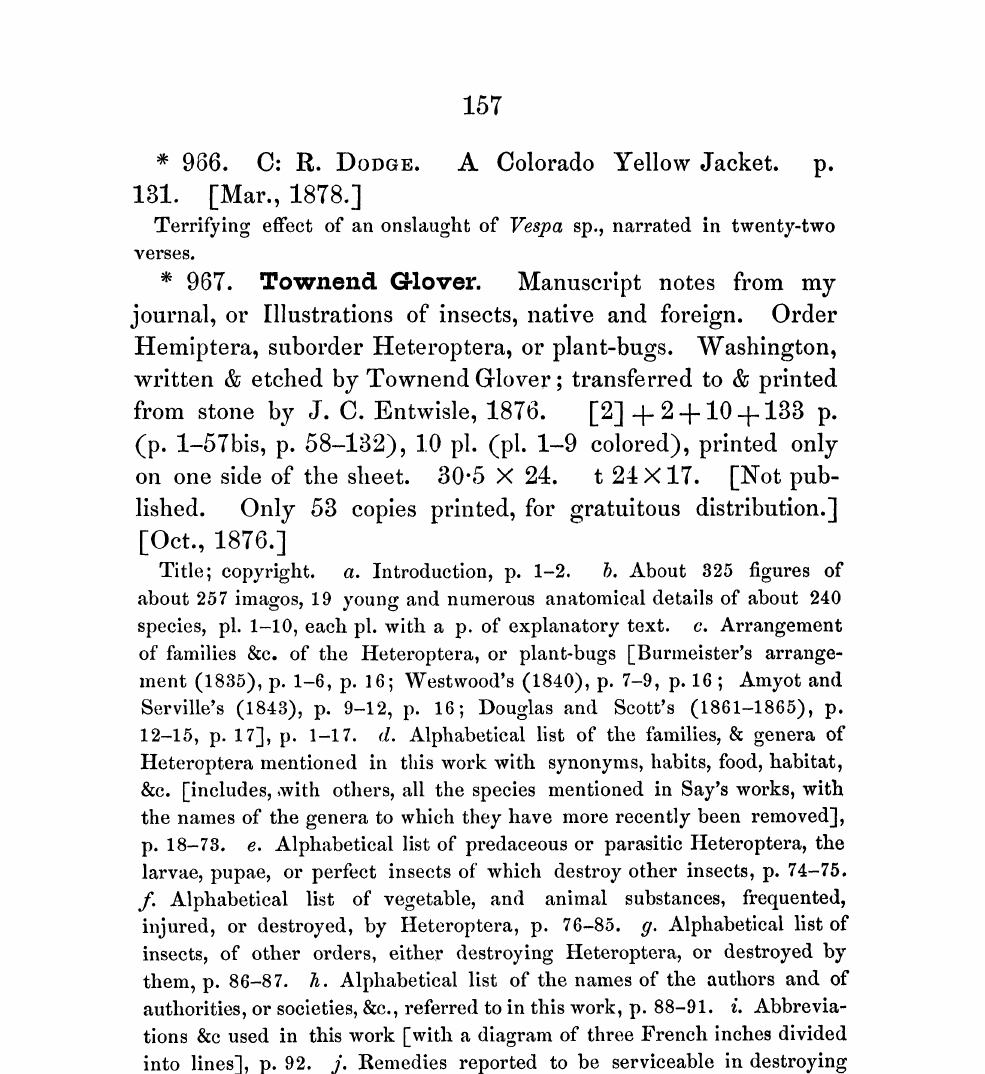
f. Alphabetical list of vegetable, and animal substances, frequented injured or destroyed, by Hetcroptera, p. 76-85. g. Alphabetical list